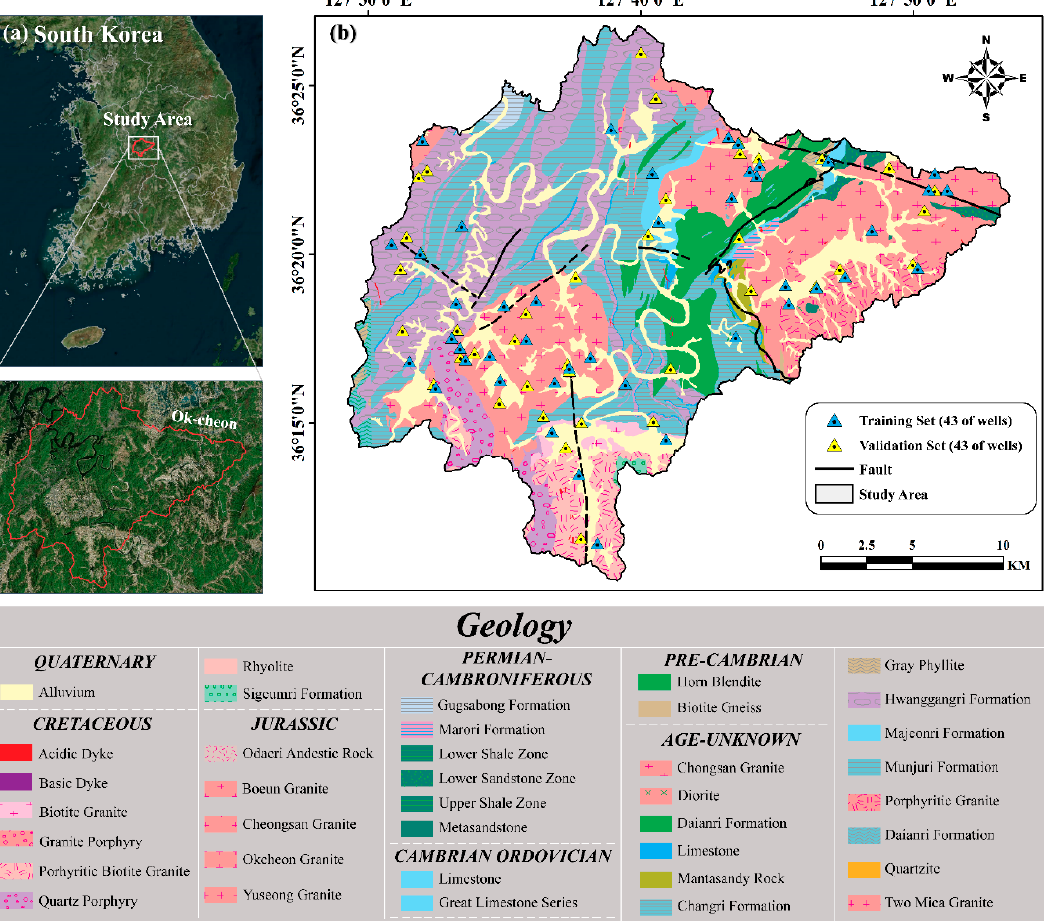
Table 1. Spatial data set related to groundwater of the study area.